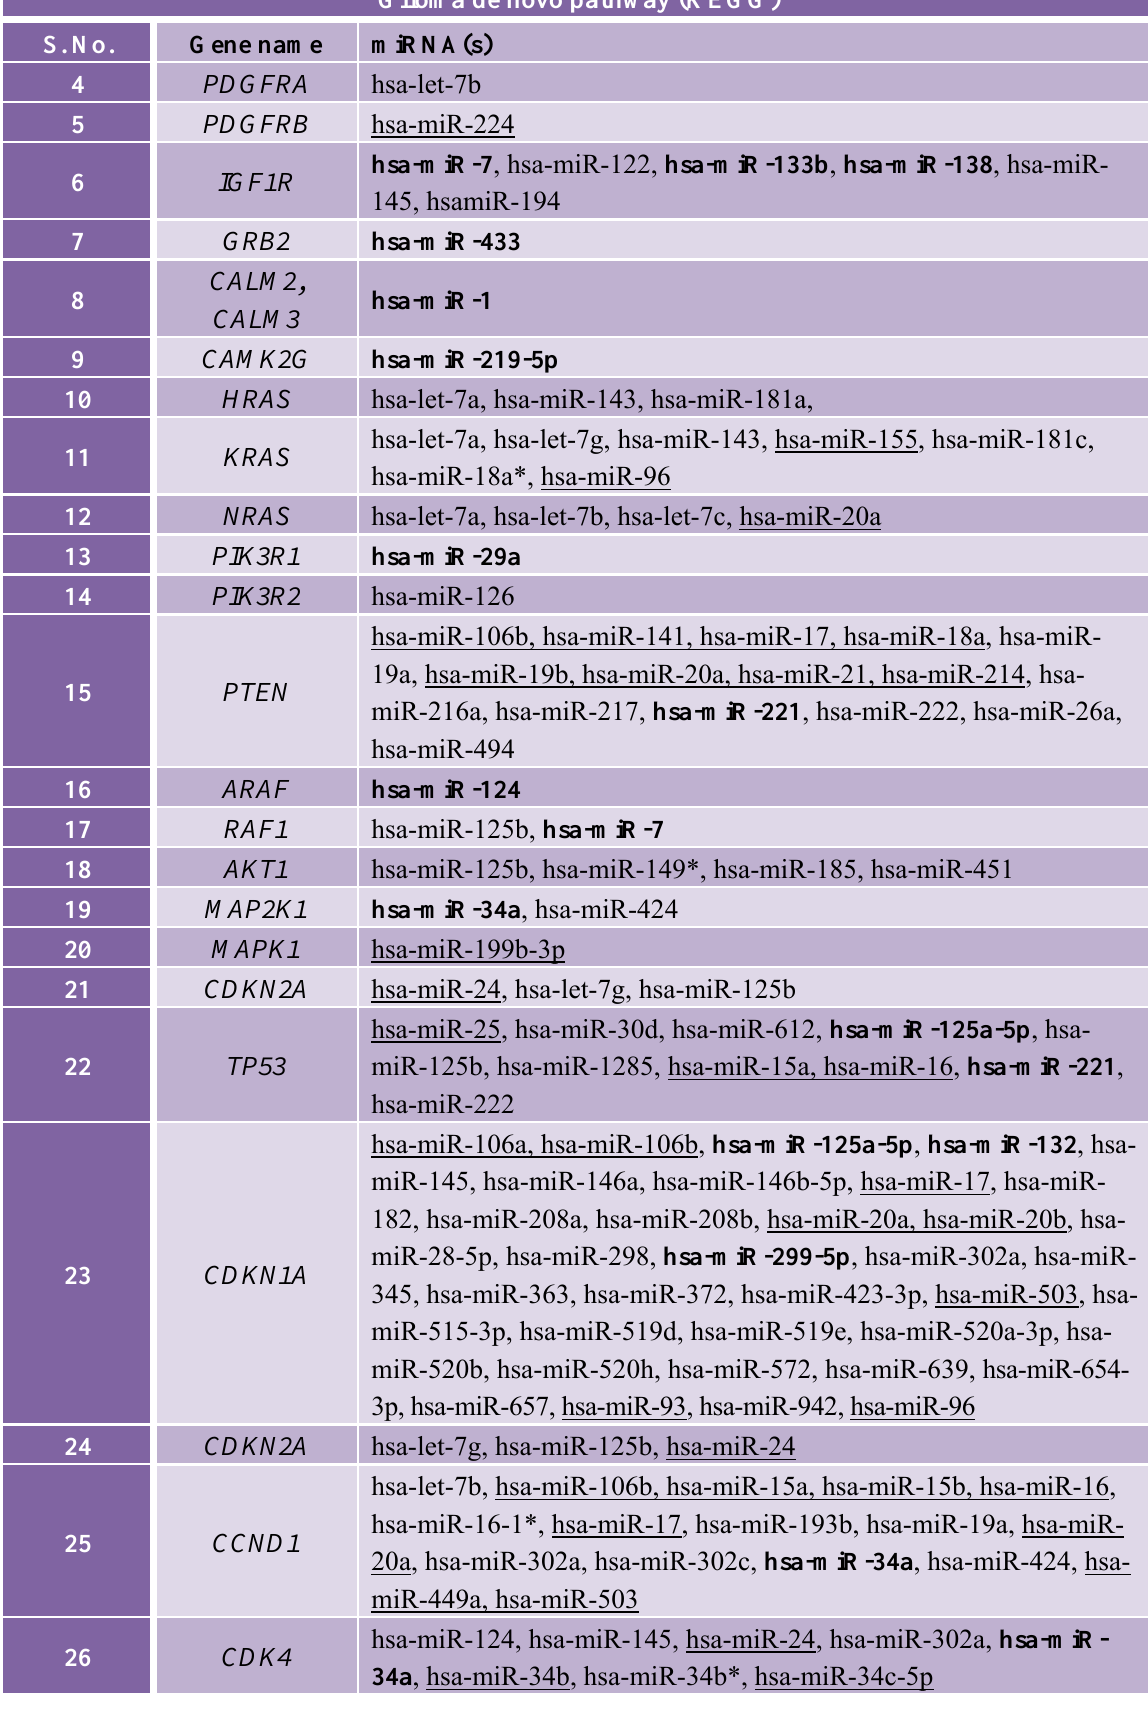
Table 2. Cont . Glioma de novo pathway